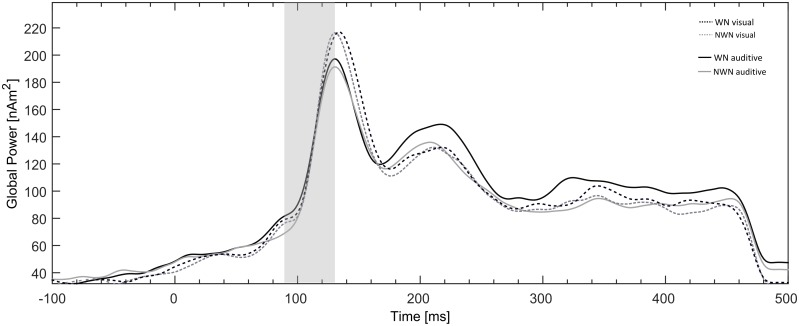
Global source power plot of the source waveforms averaged across all diploes and all subjects.Neural activities evoked by the TT following white noise (WN, black) or notched white noise (NWN, grey) during the visual task (dotted line) and the auditory task (solid line). The a priori defined N1m time interval (70–130ms) of interest is highlighted in grey.